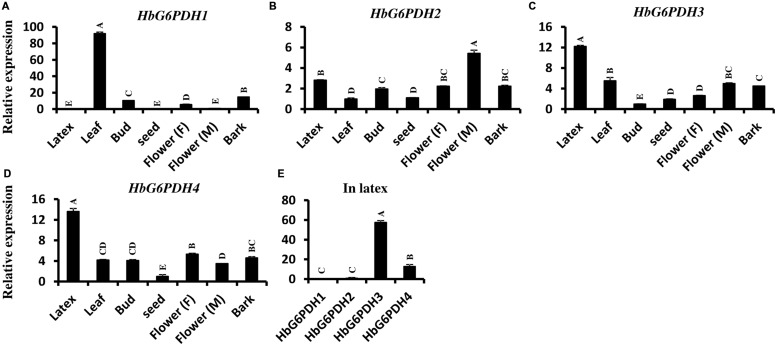
Expression of four HbG6PDH isoforms in different tissues. (A)
HbG6PDH1; (B)
HbG6PDH2; (C)
HbG6PDH3; (D)
HbG6PDH4; (E) Relative expression of four HbG6PDH isoforms in the latex. Flower (M) = male flower; Flower (F) = female flower. Different capital letters indicate a significant difference at 0.01 level.